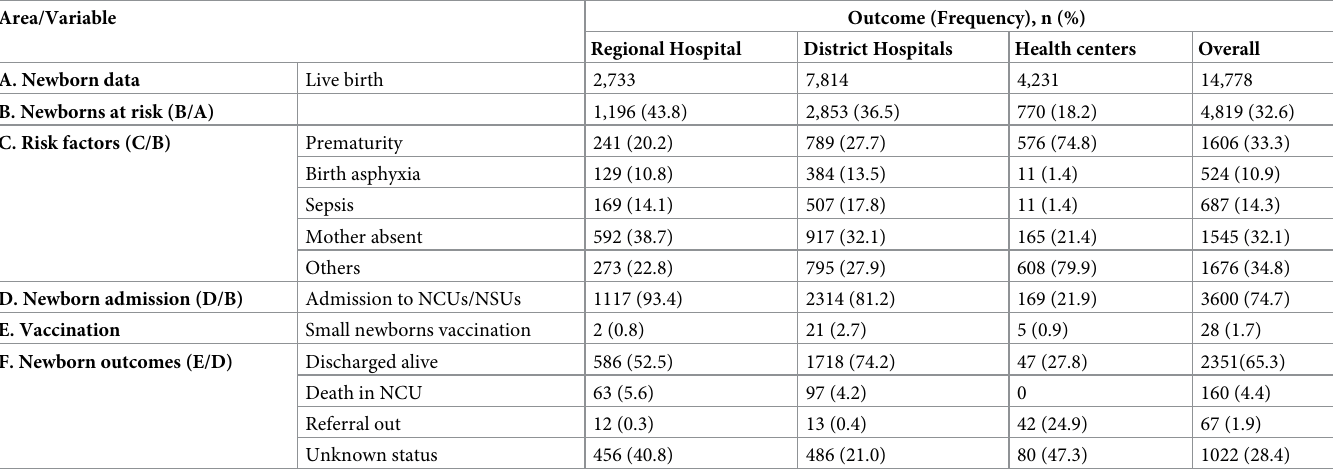
Table 2. Newborn service provision status by HF level HF-based registers.